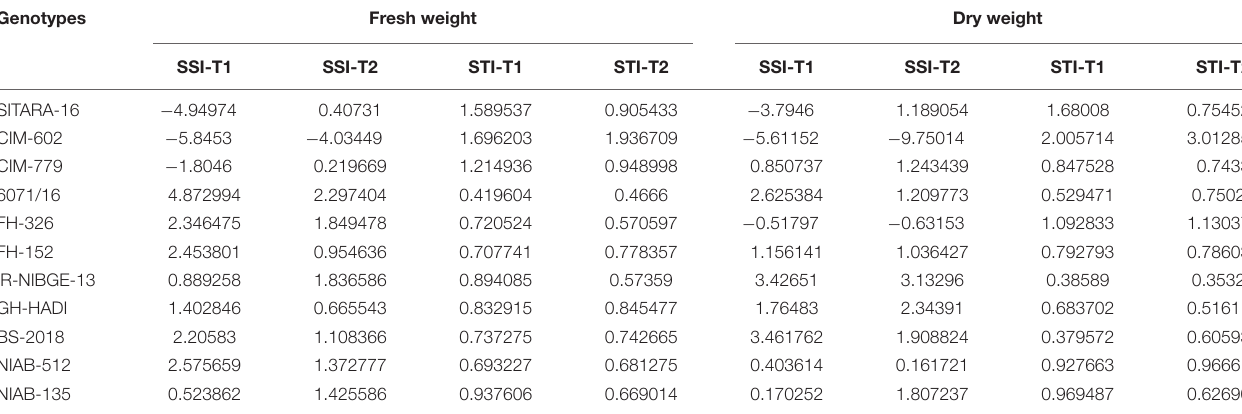
TABLE 5 | Stress susceptibility and tolerance Indices for fresh and dry weights.